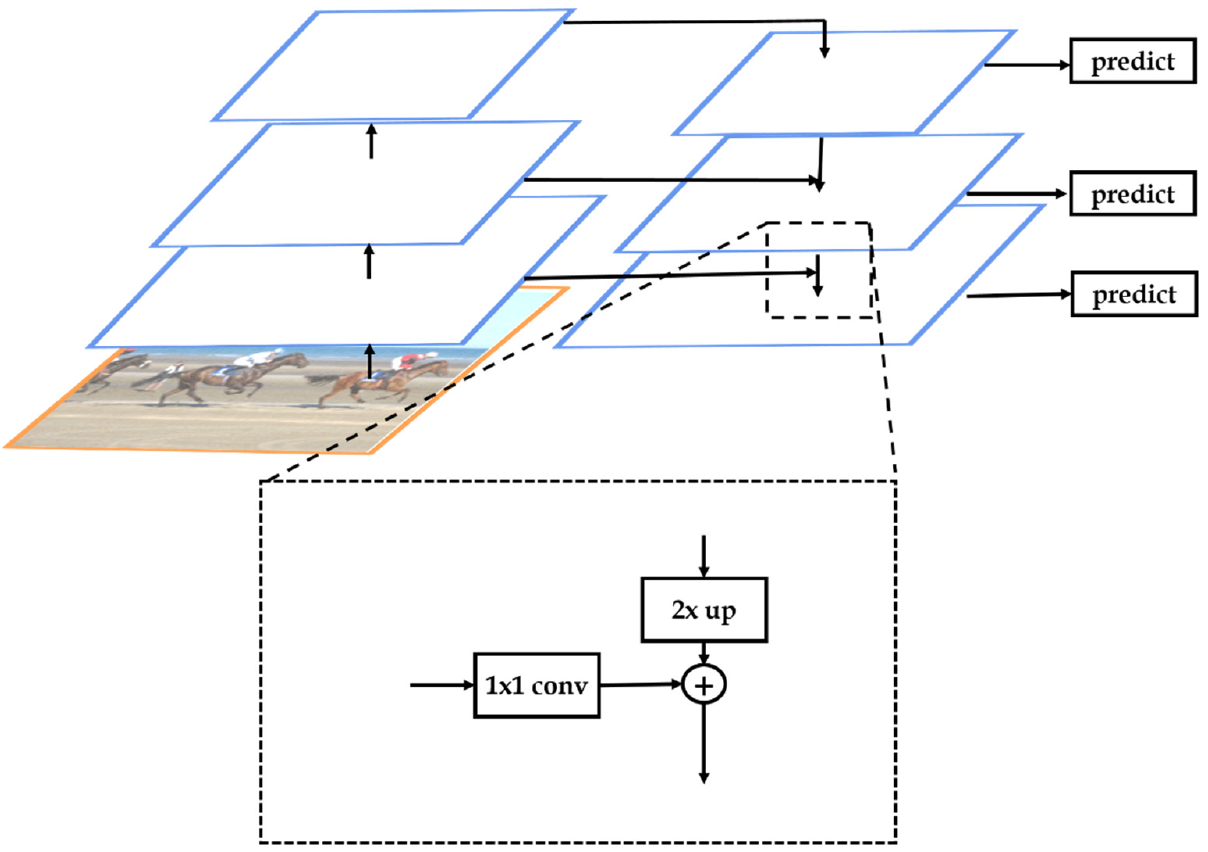
Figure 5. Detailed architecture of FPN [2].